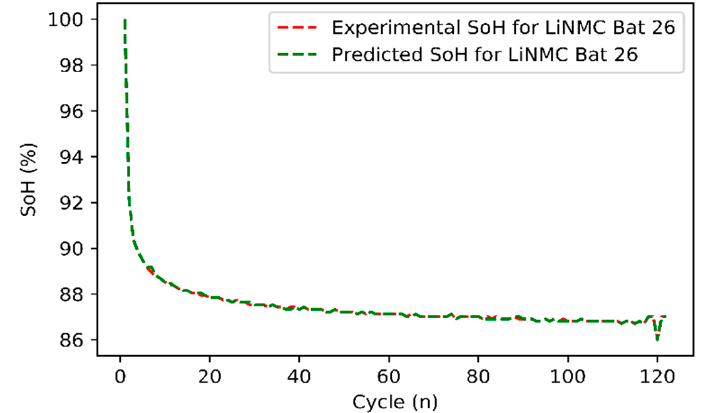
Figure 7. The SOH prediction of battery 26.